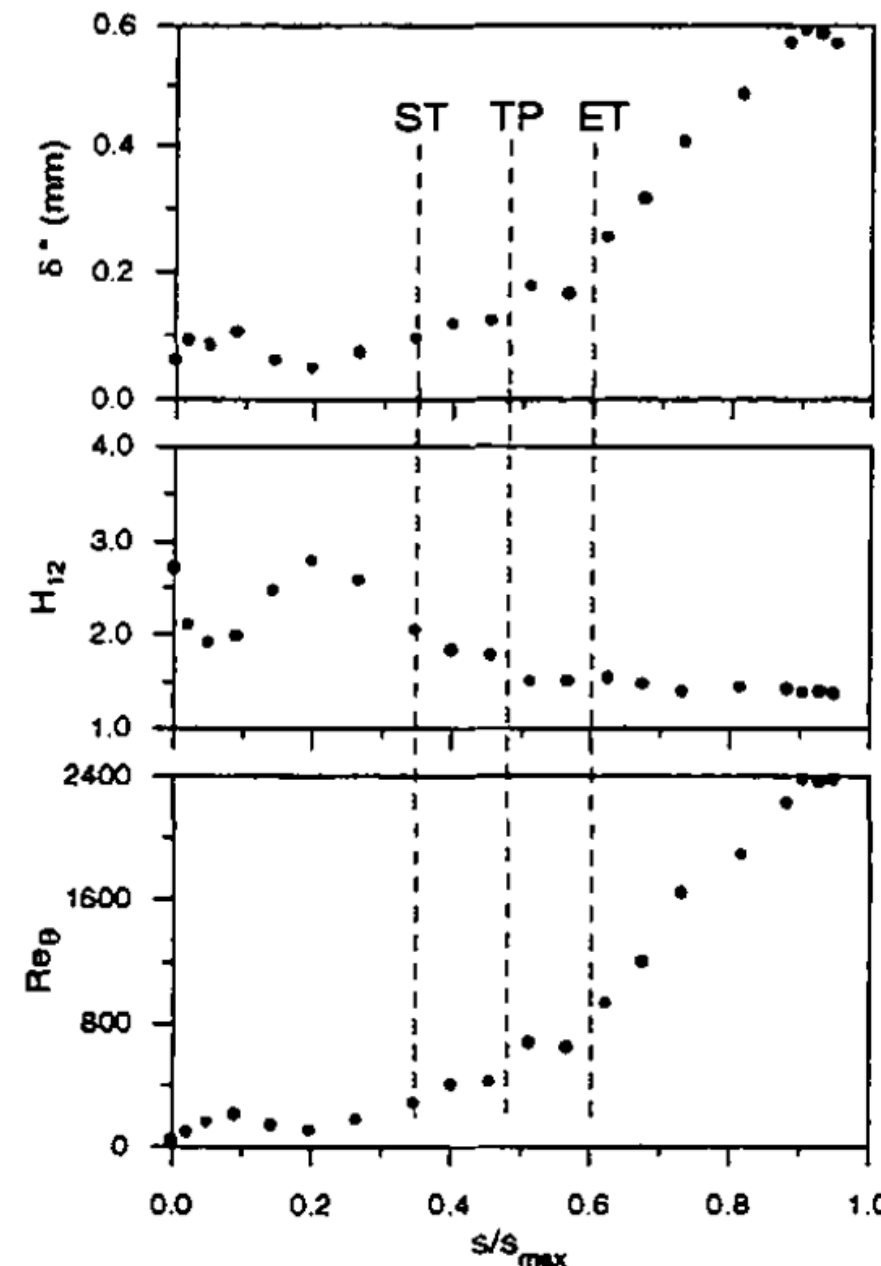
Figure A2. Boundary layer integral parameters on the blade suction